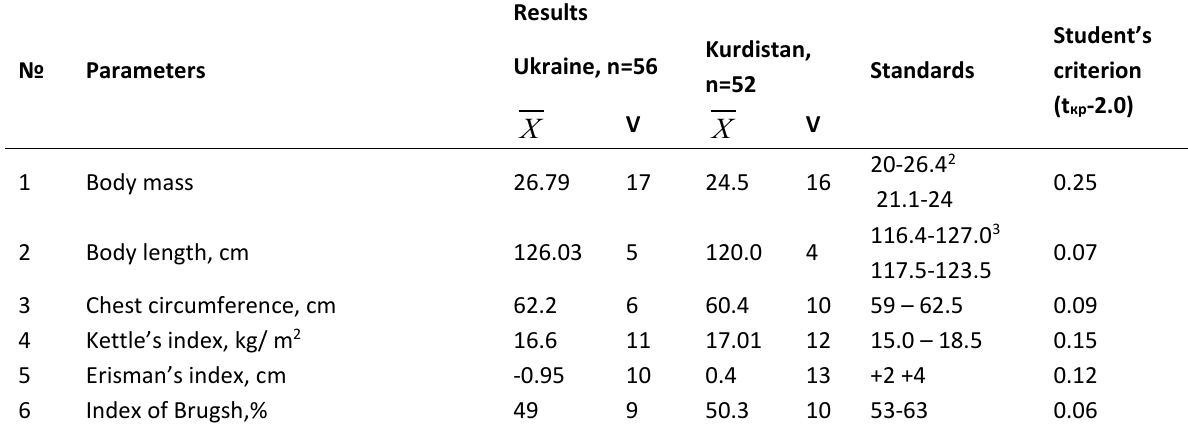
Table 2. Morphological functional indicators of 7 years’ age Ukrainian and Kurdistan